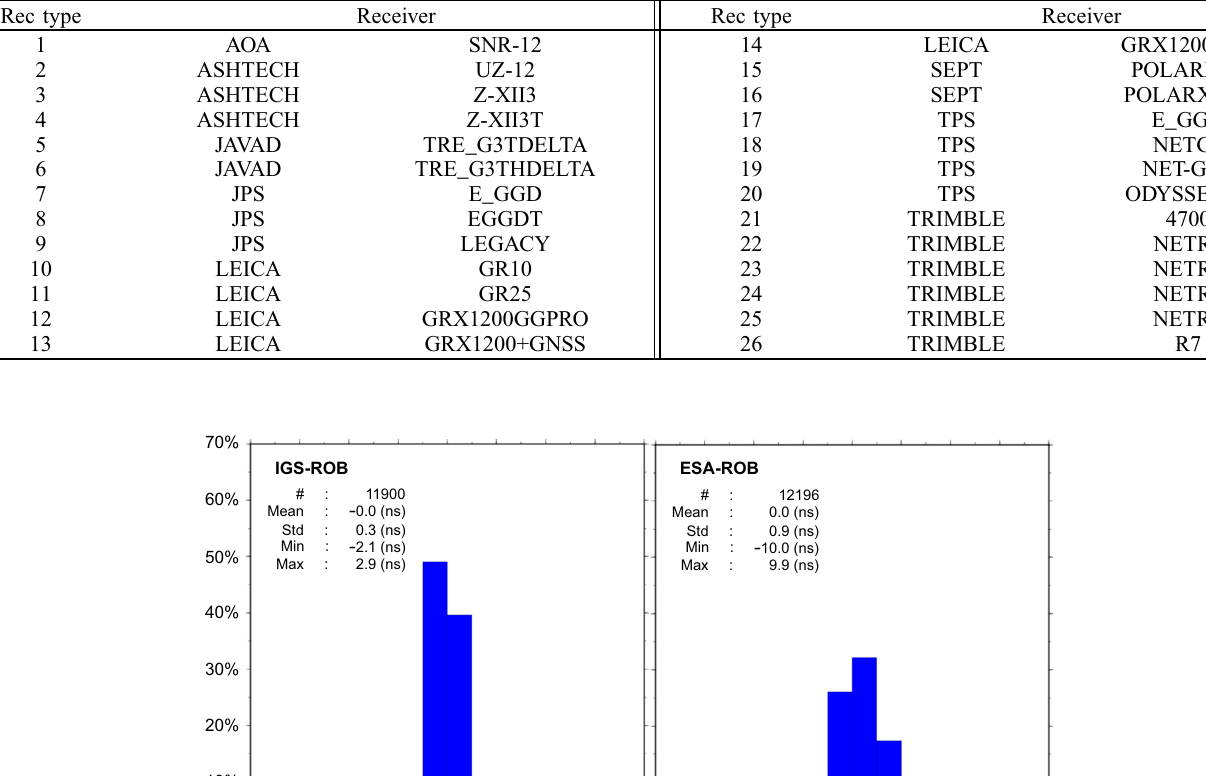
Table 1. Receiver types corresponding to Figure 1. Rec